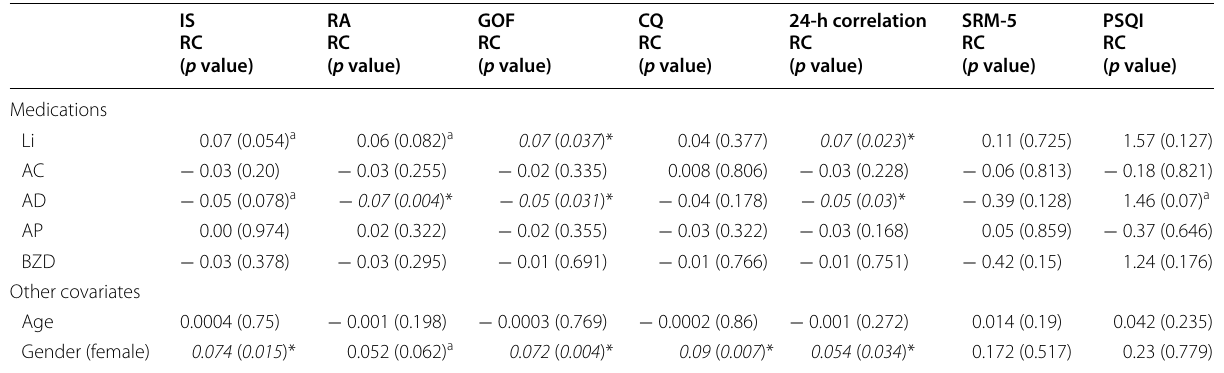
Table 4 Associations between cofactors and chronobiological variables